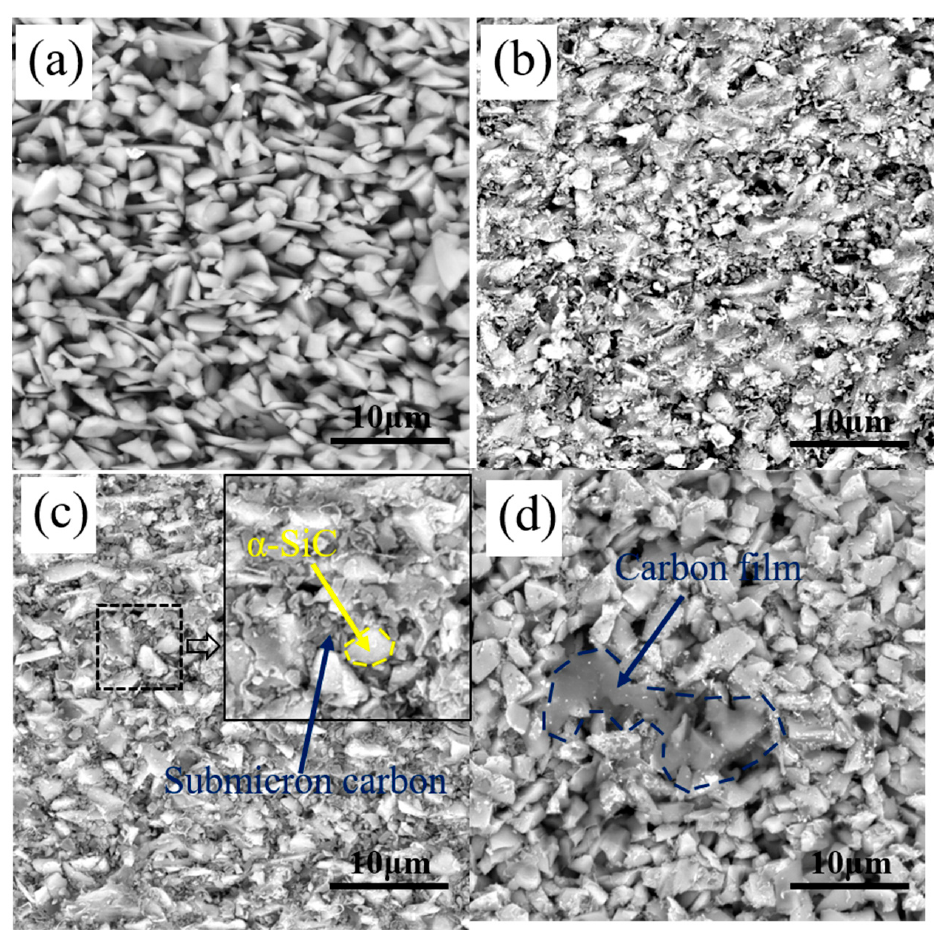
Figure 5. The microstructure of: ( a ) G0, ( b ) G10, ( c ) G20 and ( d ) G30.